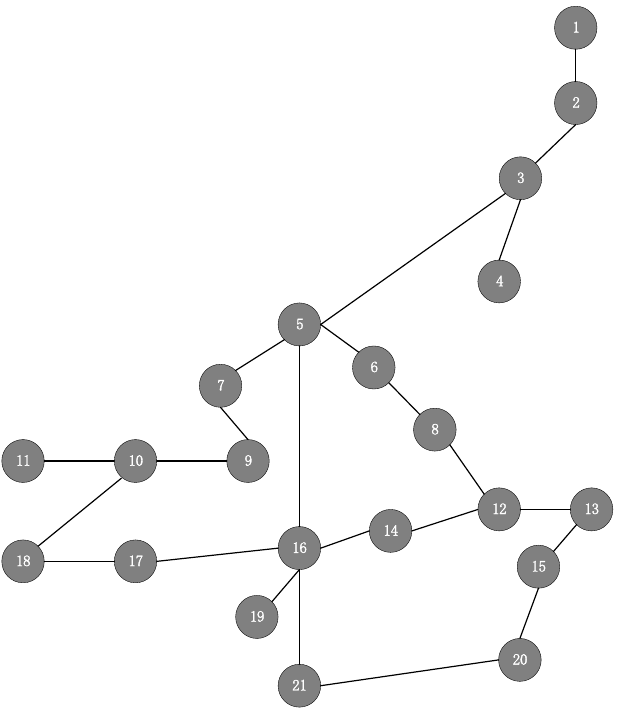
Figure 5. CERNET2 network